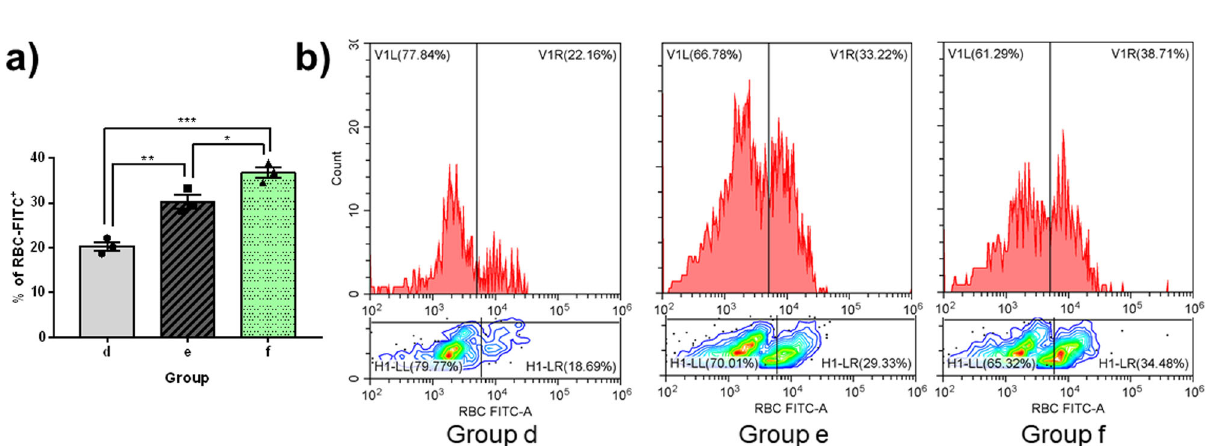
Fig. 6 Erythrophagocytosis study on primary-cultured microglia in vitro. PKH-26 labeled whole RBCs were cocultured with microglia for 1 h before being removed by PBS washing. Engulfed fl uorescent RBCs remained within the fl ask-adherent microglia and were analyzed via fl ow cytometry with the FITC channel. a Phagocytic activity was highest in Group F (previous RBC coculture with T cells), second highest in Group E (previous RBC coculture), and lowest in Group D (no previous RBC coculture). Error bars indicate SEM. * p < 0.05, ** p < 0.01. b Graphical representation of RBC-FITC +